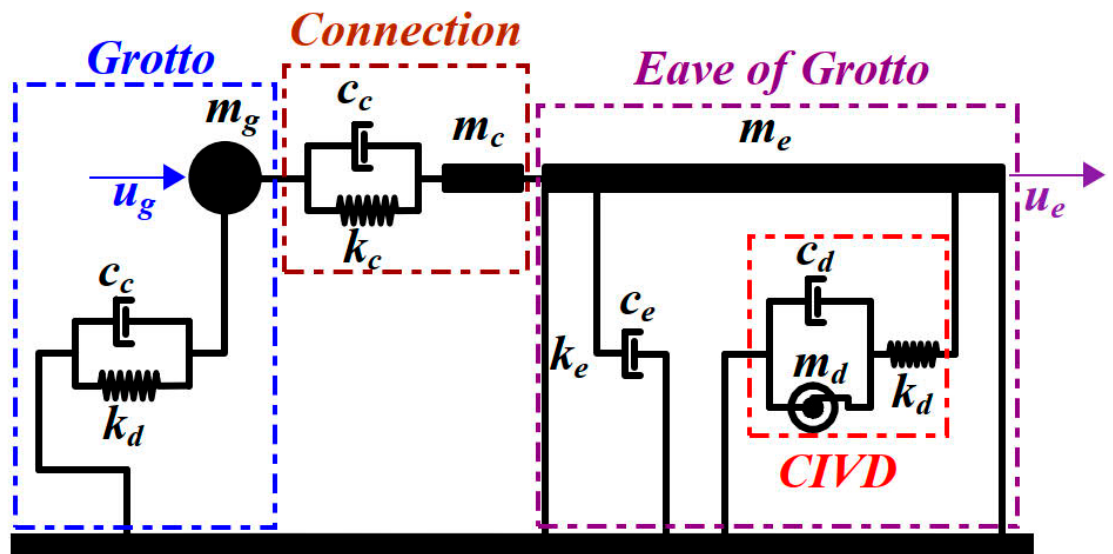
Figure 5. Mechanical model of eave–grotto system with CIVD.